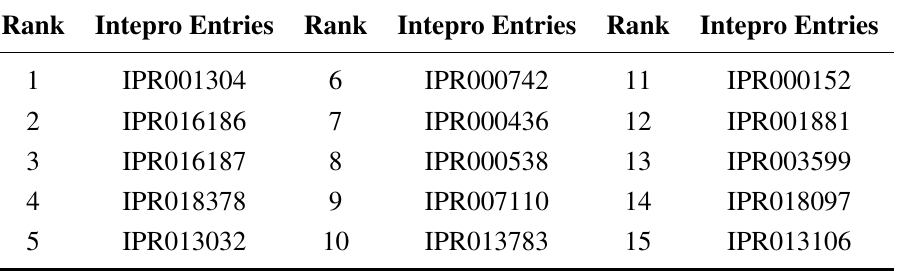
Table 7. The 15 Intepro entries that are present in more than or equal to 10 antifreeze proteins in the training